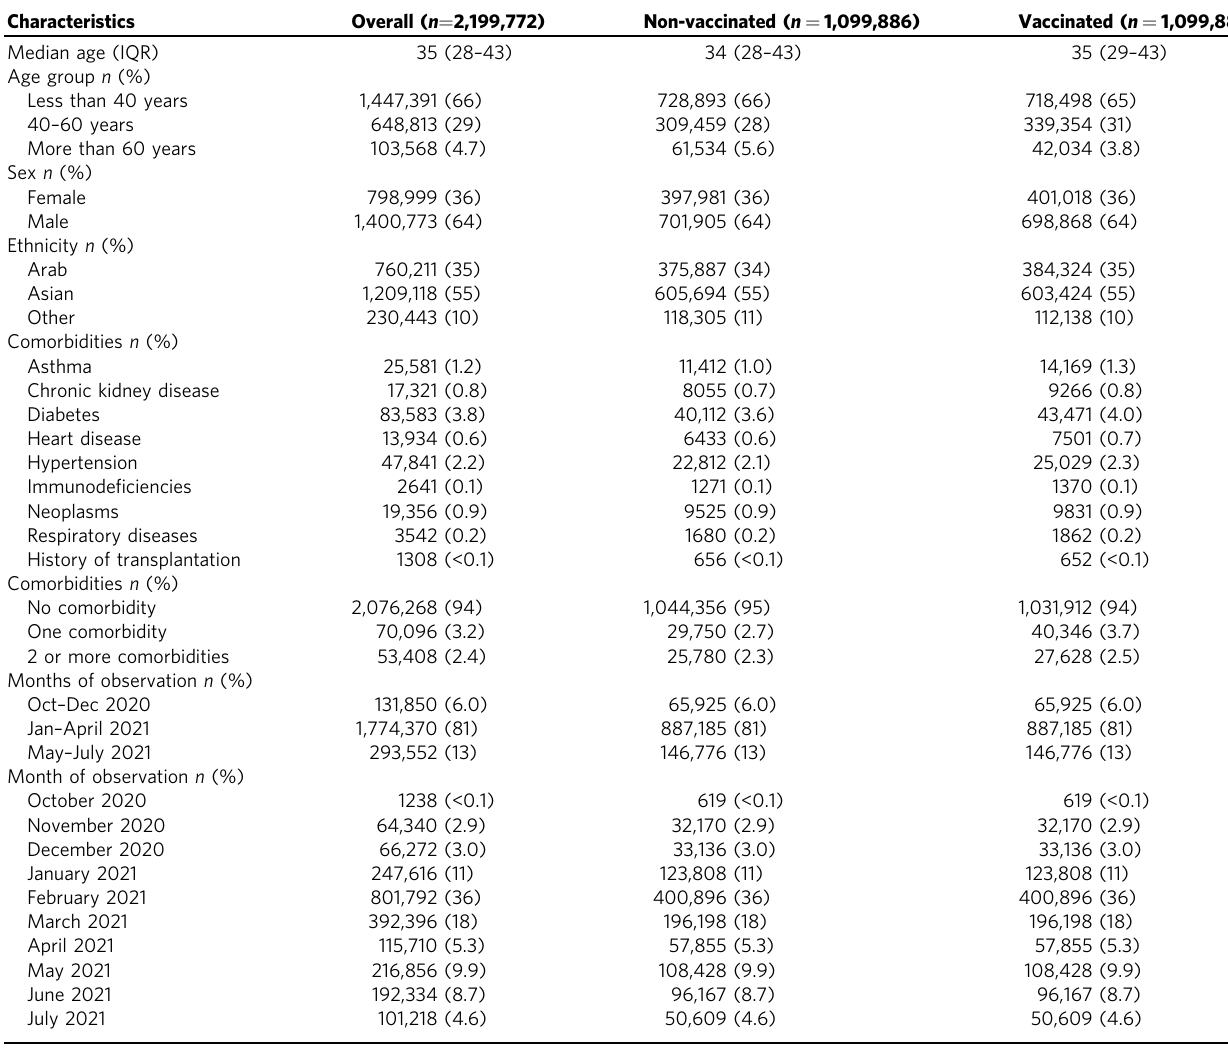
Table 1 Demographic and Clinical Characteristics of the study participants at baseline.